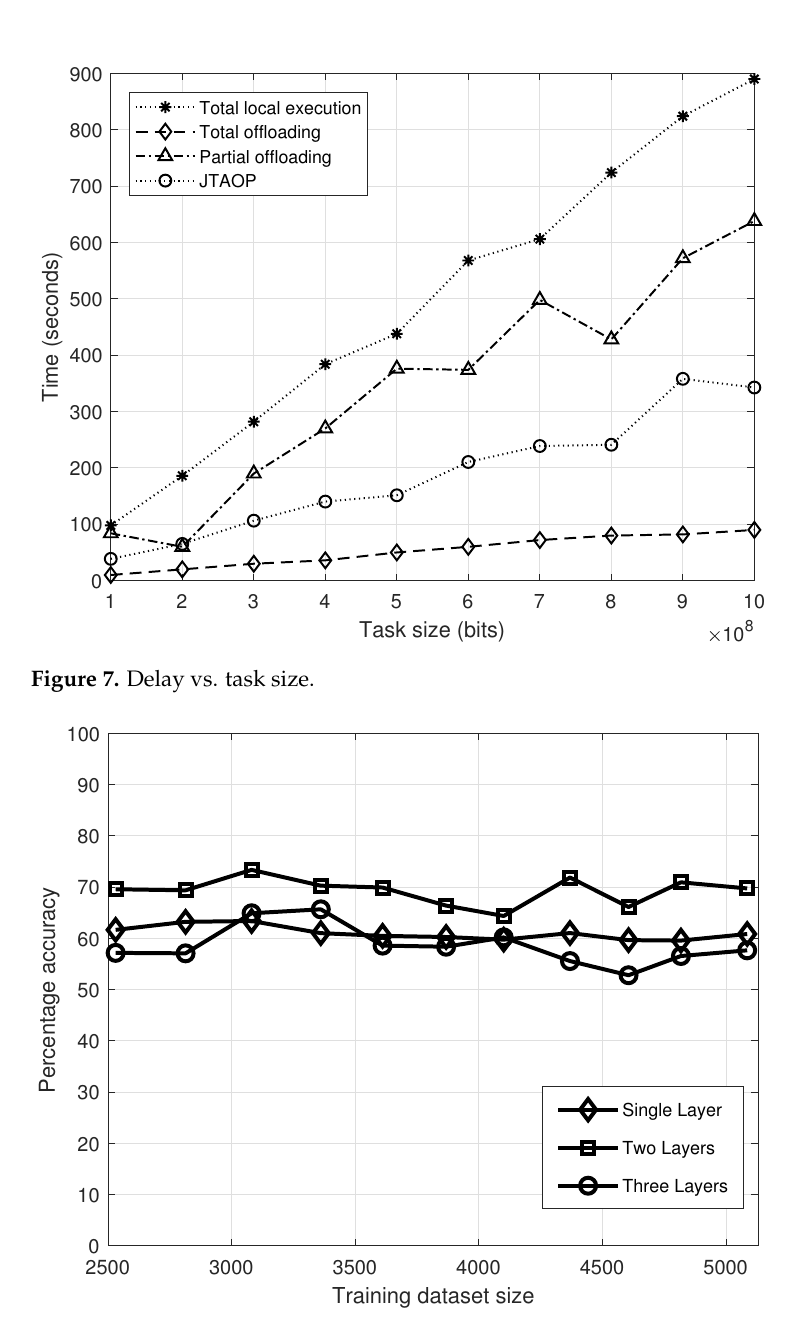
Figure 8. Neural network accuracy with different number of hidden